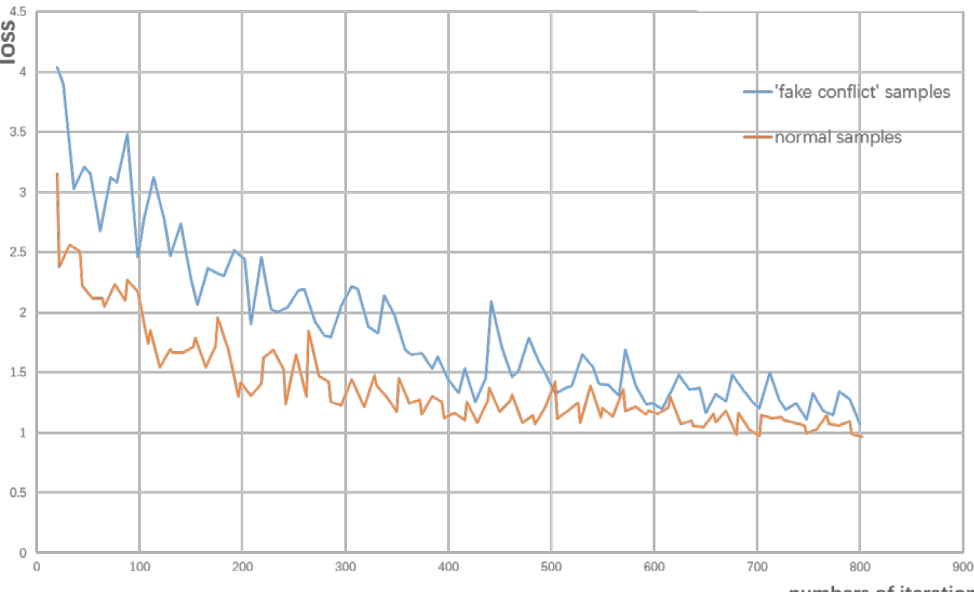
Figure 6. Loss curves when training network only with ‘fake conflict’ samples or normal samples. The x -axis represents the number of network iteration, and the y -axis represents the loss during network training.